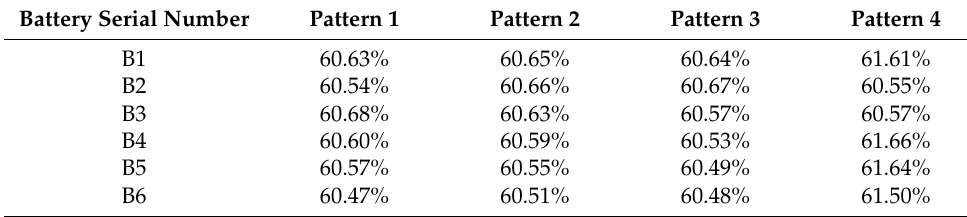
Table 5. Charge equalization experimental